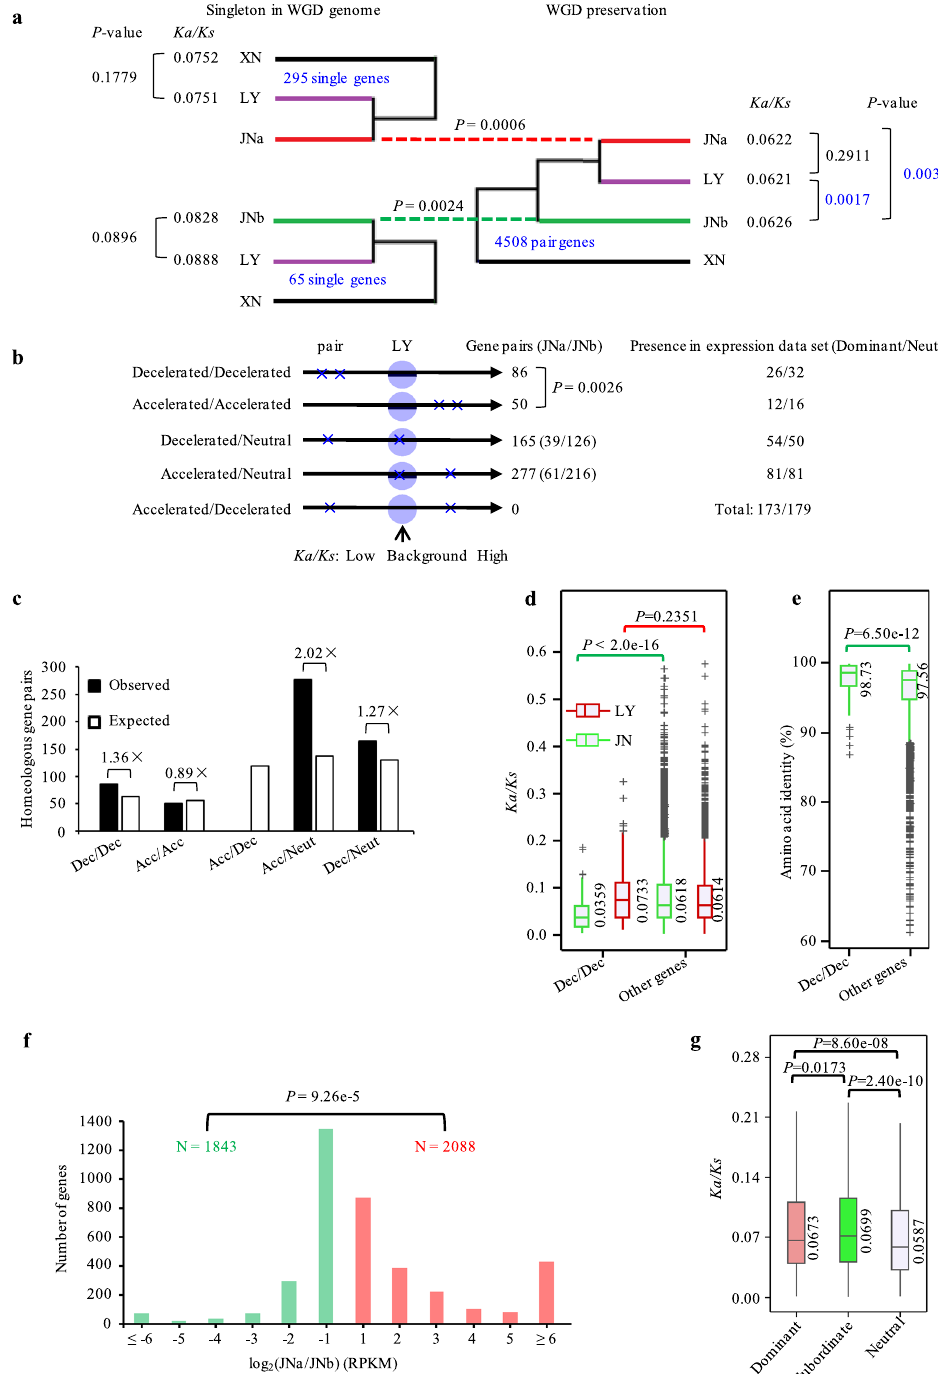
modi fi ed through deamination to inosine, which can wobble with codons ending in A, C, or T 37 . Furthermore, we calculated the equilibrium GC3 content, GC3 * , re fl ecting the AT to GC substitution rates of LY and JN compared with XN orthologs at the third codon positions. GC3 was strongly correlated with GC3 * and distributed slightly above the diagonal lines for LY, JNa, and JNb (Fig. 7b and Supplementary Fig. 23), supporting the hypothesis that the Rhizoctonia lineages faced similar selection pressures for codon usage. However, LY and JN slightly favored fi xation of GC over AT in comparison with XN, consistent with the resulting lower GC content in the XN